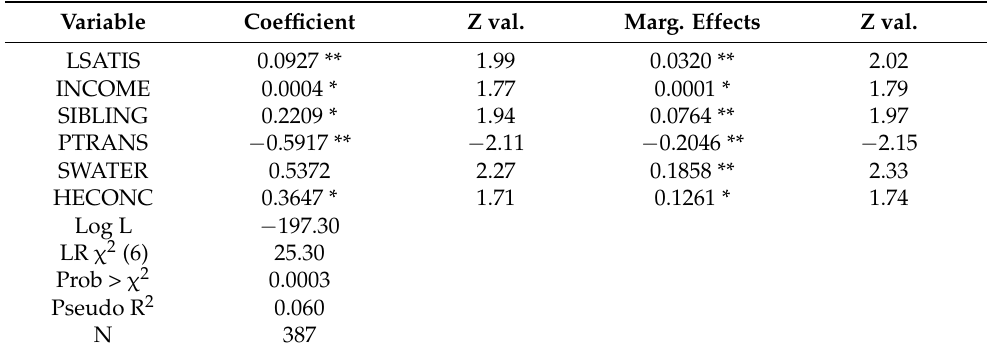
Table 8. Estimated parameters for high-cost PEB: probit